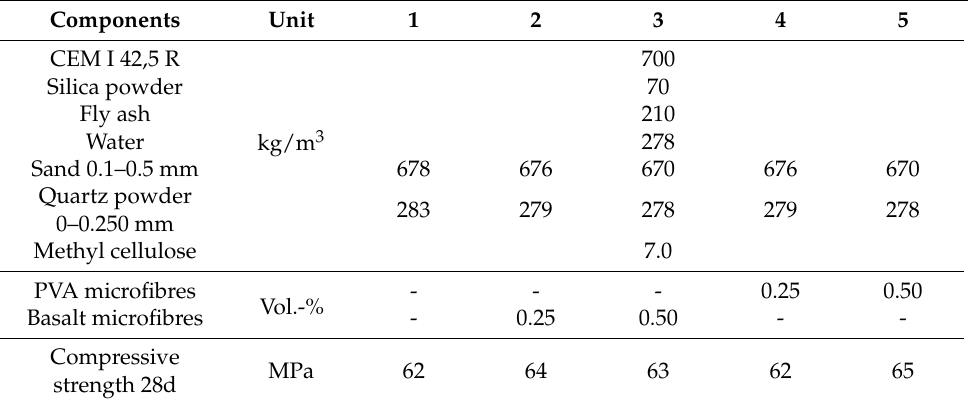
Table 1. Mix design of the investigated